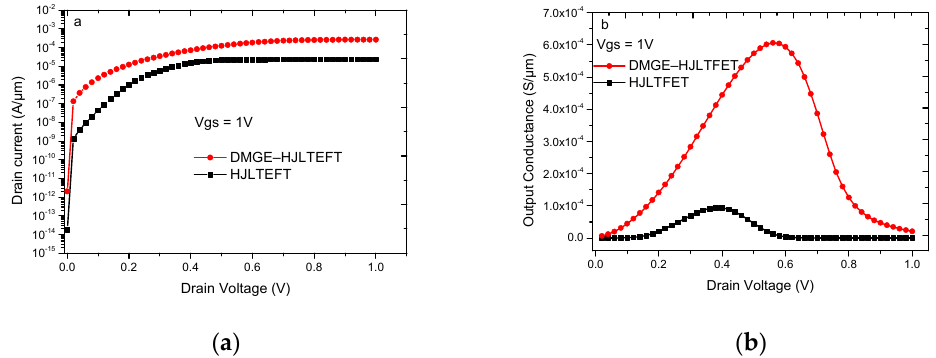
Figure 5. ( a ) Output characteristics of the HJLTFET and DMGE-HJLTFET at gate-to-source voltage (Vgs) = 1 V; ( b ) output transconductance of the HJLTFET and DMGE-HJLTFET at Vgs = 1 V.